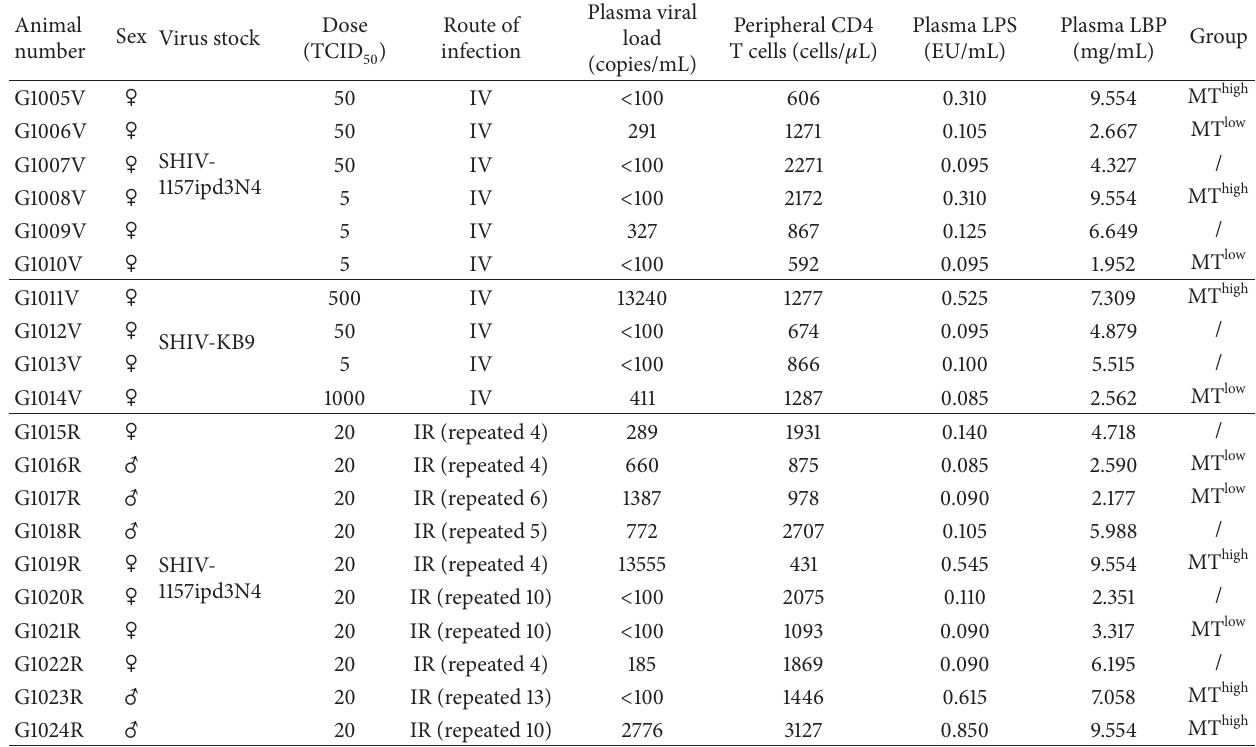
Table 1: Summary of viruses and associated experimental parameters used in the first part of the study.